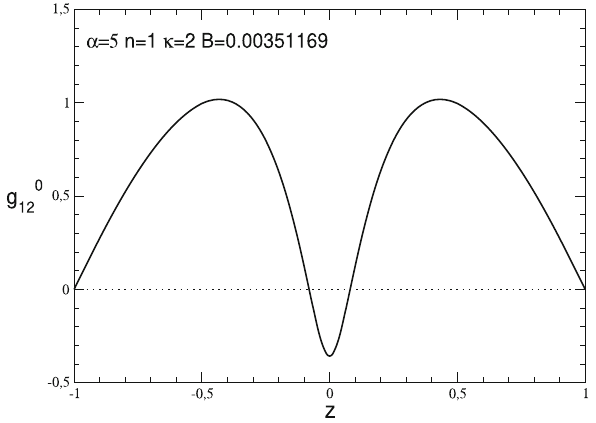
Fig. 4 g 0 for the abnormal state No. 3 of Table 1 12